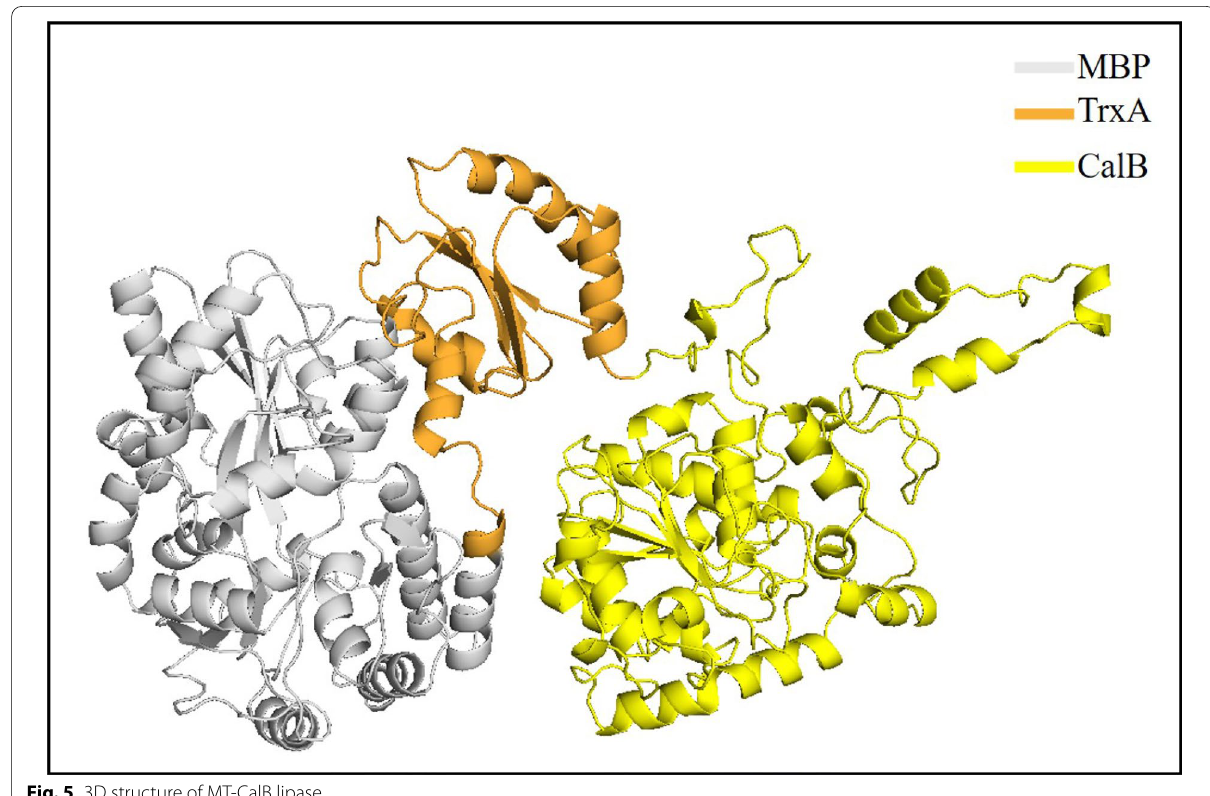
Fig. 5 3D structure of MT‑CalB lipase